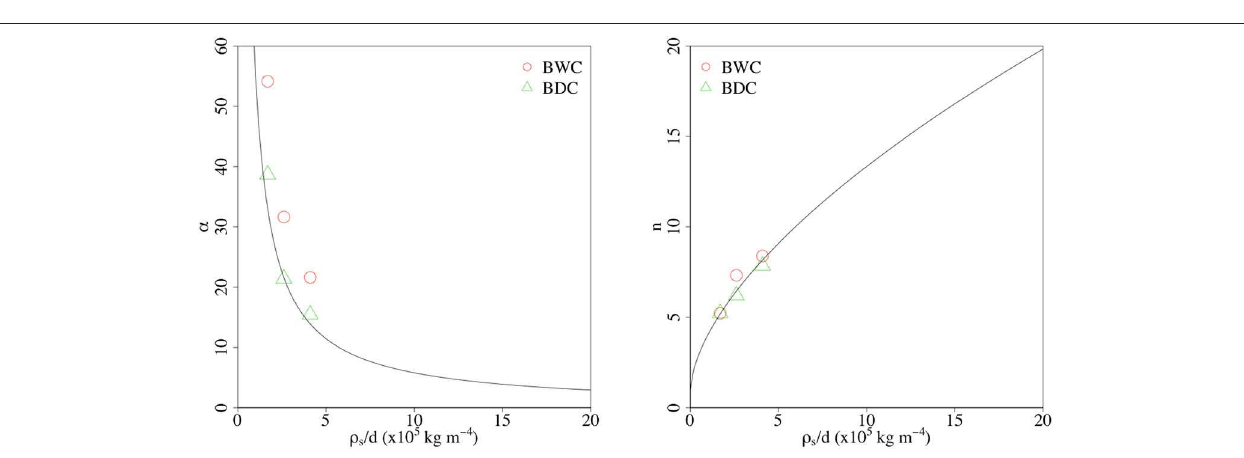
FIGURE 7 | Comparison results between α , n (Equation 5). Red circles are results of boundary wetting curve (BWC) and green triangles are results of boundary drainage curve (BDC). Black curves are calculated curves using the equation of Yamaguchi et al. (2012) with ρ s / d . ρ s / d , ratio of snow density and grain size.